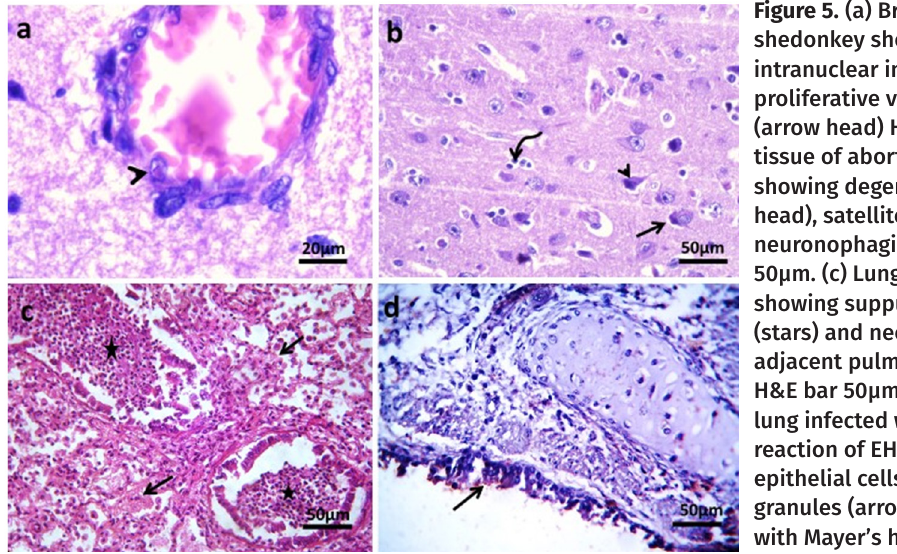
Table III. Summarized the main histopathological lesions scores among examined organs of fetal and neonatal tissues beside placentae.